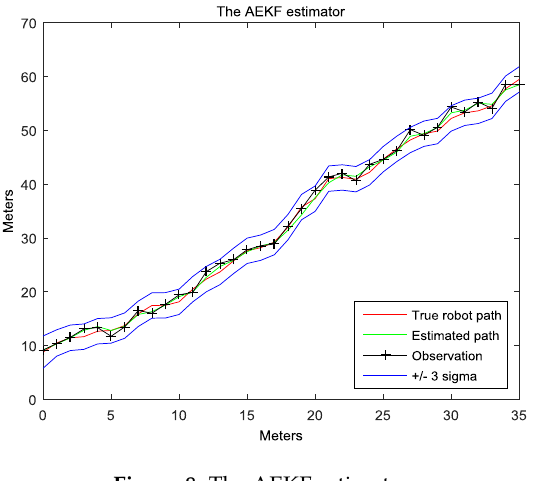
Figure 8. The AEKF estimator.